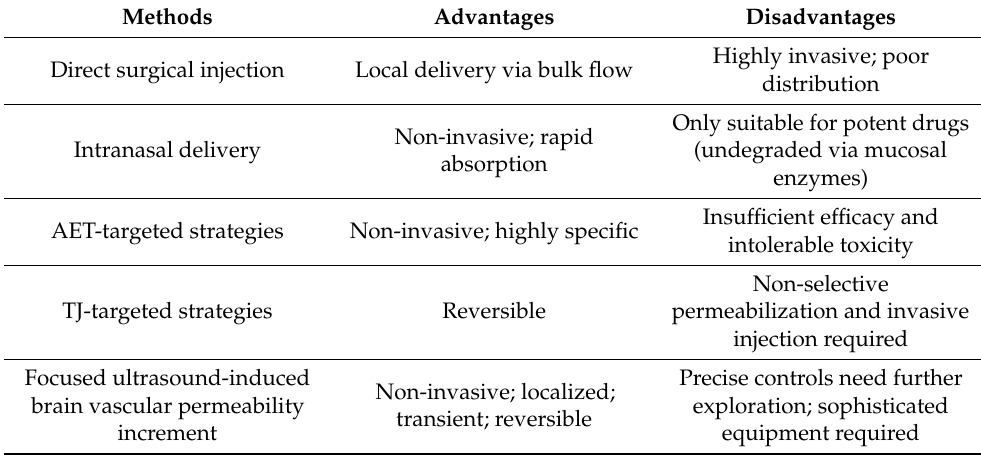
Table 1. Summary of strategies overcoming blood–brain barrier (BBB)/blood–brain–tumor bar- rier